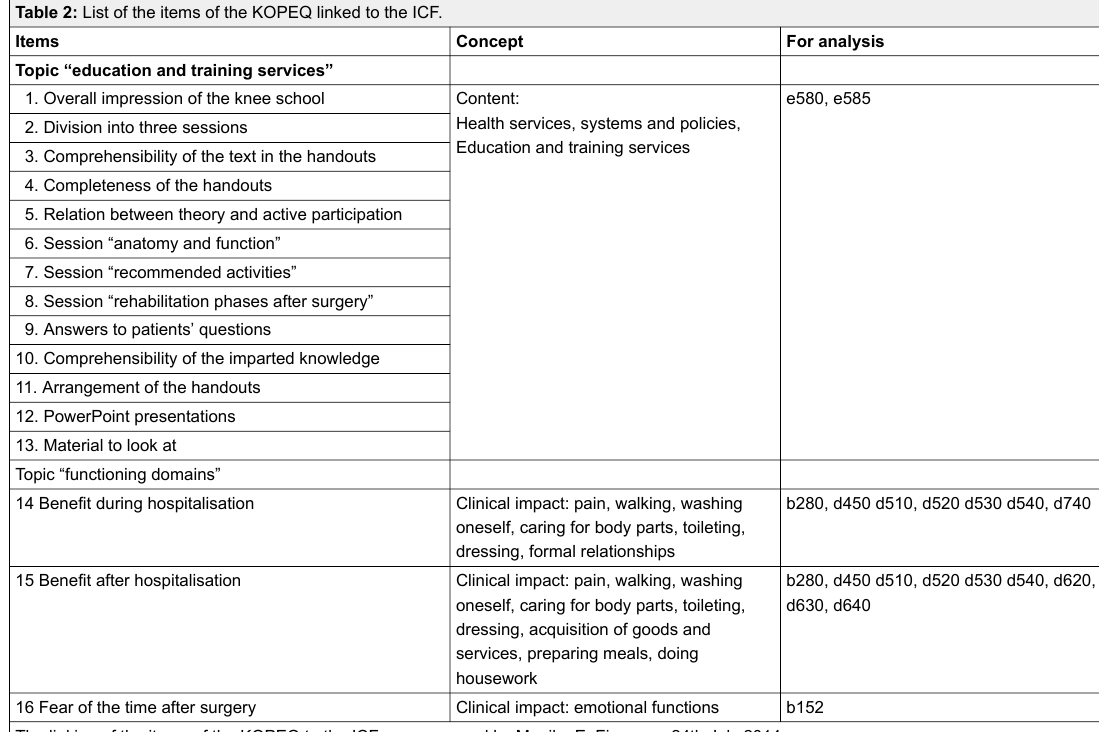
Table 2: List of the items of the KOPEQ linked to the